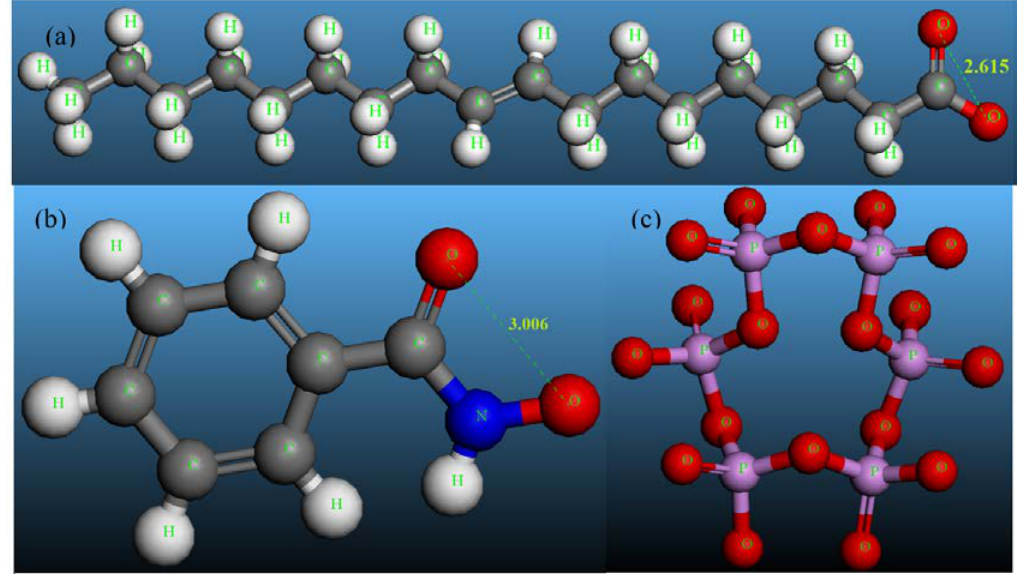
Figure 1. Molecule structures of Ol − ( a ), benzohydroxamic acid (BHA) ( b ), and (PO 3 ) 6 − gray, C; red, O; pink, P; blue, N).